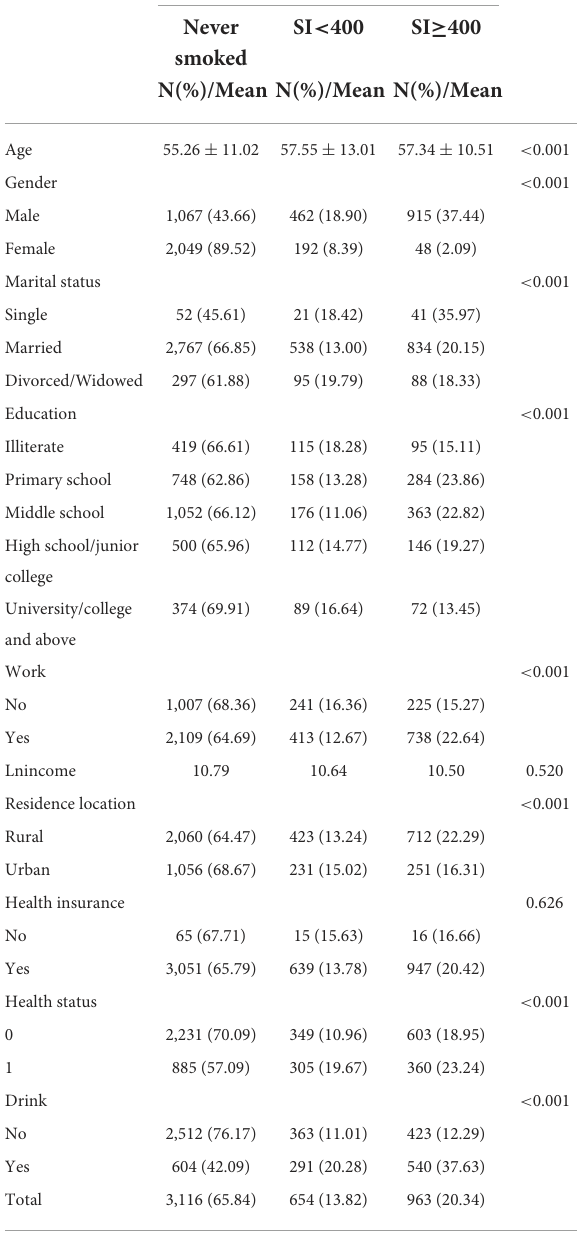
TABLE 2 Description of the selected samples of Chinese adults ≥ 40 years old by smoking status ( N = 4,733).